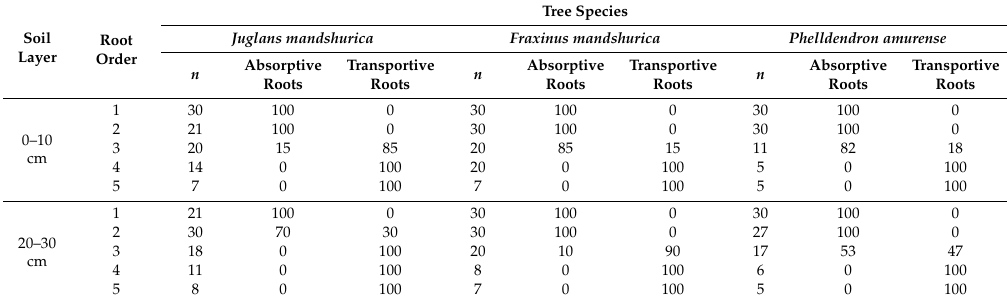
Figure 1. Typical anatomical structures the first five orders of roots in surface (0–10 cm) and subsurface (20–30 cm) soil layers in Juglans mandshurica , Fraxinus mandshurica, and Phellodendron amurense . Table 1. The relative abundance (%) of absorptive and transportive fine roots in three hardwood species at surface (0–10 cm) and subface (20–30 cm) soil